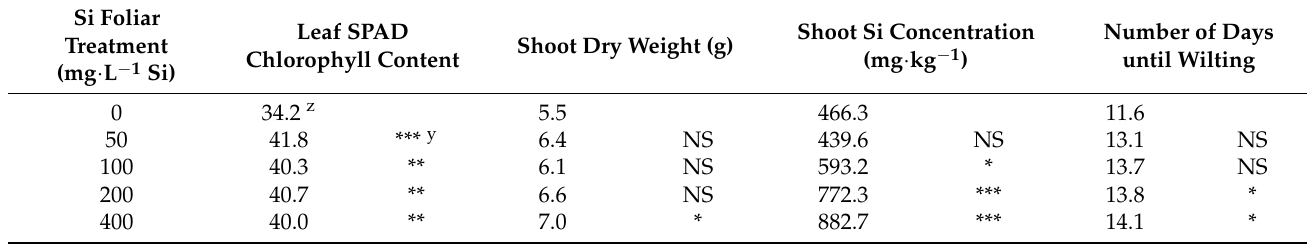
z Data represent least-square means of four replicates for the individual Si foliar spray treatments (50, 100, 200, 400 mg · L –1 Si) and eight replicates for the 0 mg · L –1 Si control. Single degree-of-freedom contrasts were used to compare each Si foliar treatment to the control. y NS, *, **, *** Non-significant or significant at p ≤ 0.05, 0.01, or 0.0001, respectively, for comparison of each Si foliar spray treatment (50, 100, 200, 400 mg · L –1 Si) to the 0 mg · L –1 Si control. See Table 1 for p